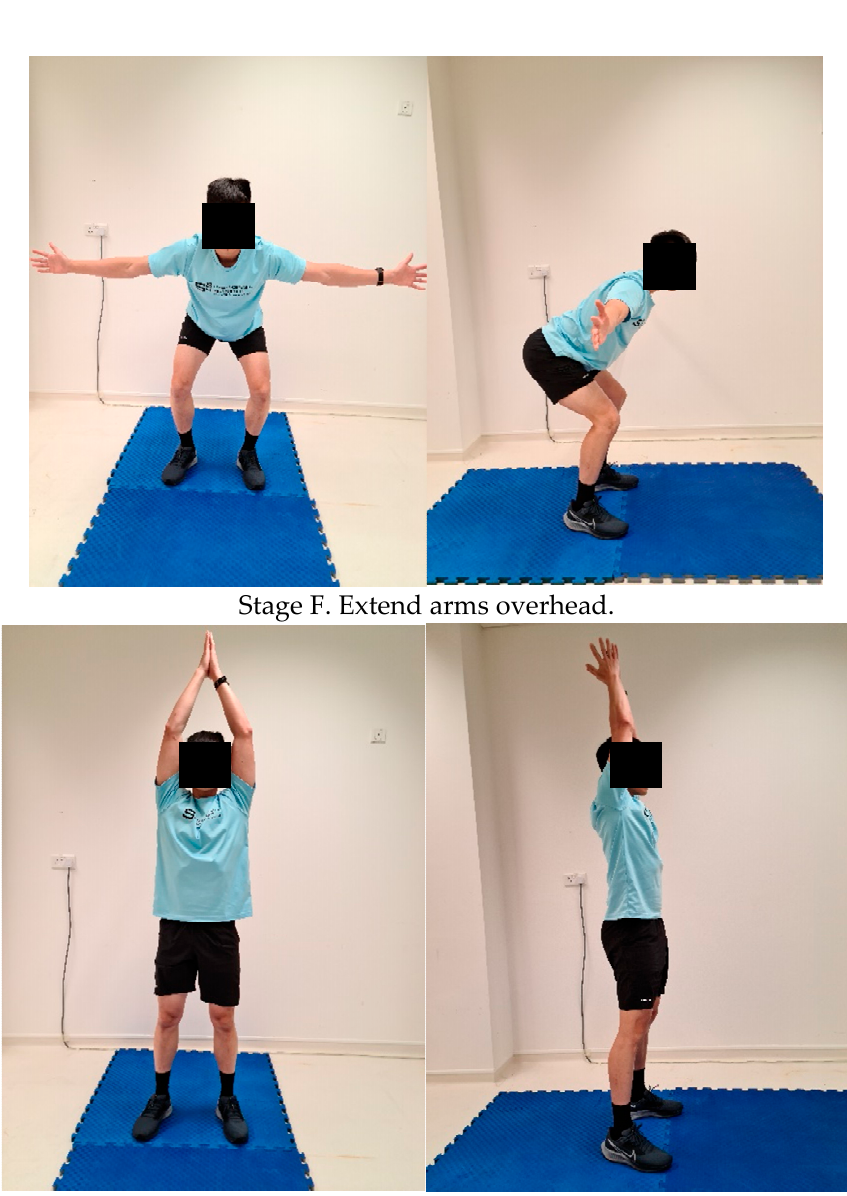
Figure 1. The study’s standard burpee movements with specific